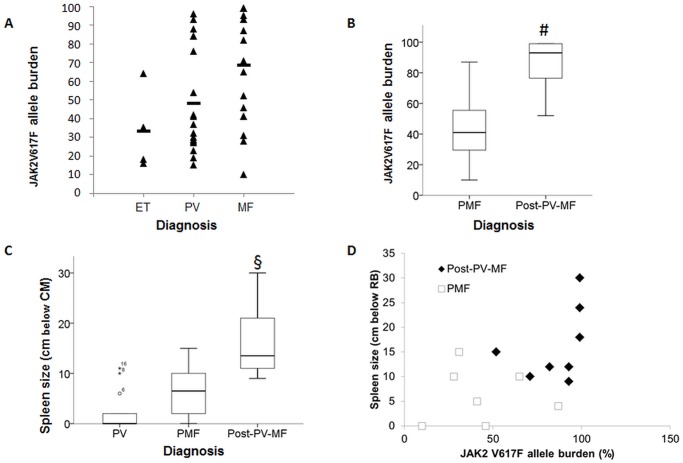
JAK2 V617F allele burden differs in the indicated entities.(A) Analysis of the JAK2 allele burden of JAK2 V617F positive MPN samples: ET n = 4, PV n = 17, MF n = 16. Black bars show the mean allele burden. The allele burden showed significant differences even in a small subgroup of MPN samples (see text). (B) Addressing only the MF samples (n = 16), pMF samples (7/16) had a significant lower allele burden compared to Post-PV-MF samples (8/16); # p<0–01 (T-Test), the one Post-ET-MF sample was not included in this analysis. (C) The extent of splenomegaly of the different MPN (ET, PV, MF) was different in indicated entities (presented in cm below costal margin), e.g. spleen size of Post-PV-MF was largest vs. PMF and PV (p<0.01, One-way ANOVA and LSD testing). (D) Relationship between JAK2 allele burden and spleen size. A higher allele burden was associated with a larger spleen in post-PV-MF (R2 = 0,1841) but not in PMF (R2 = 0,00002). Abbrevations in this figure are the same as used in the text.